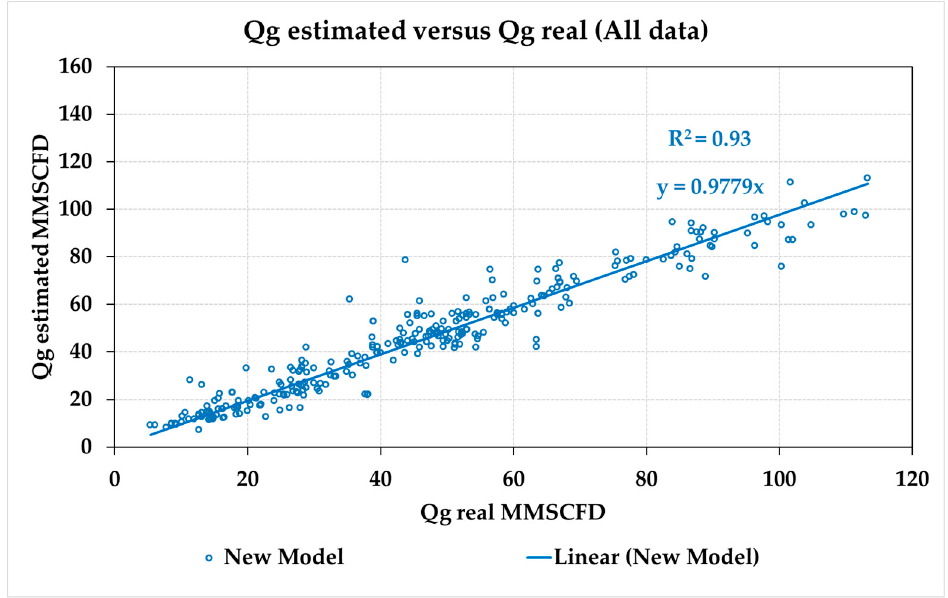
Figure 1 . Estimated gas flow rate versus real gas flow rate (all data) . Figure 1. Estimated gas flow rate versus real gas flow rate (all data).